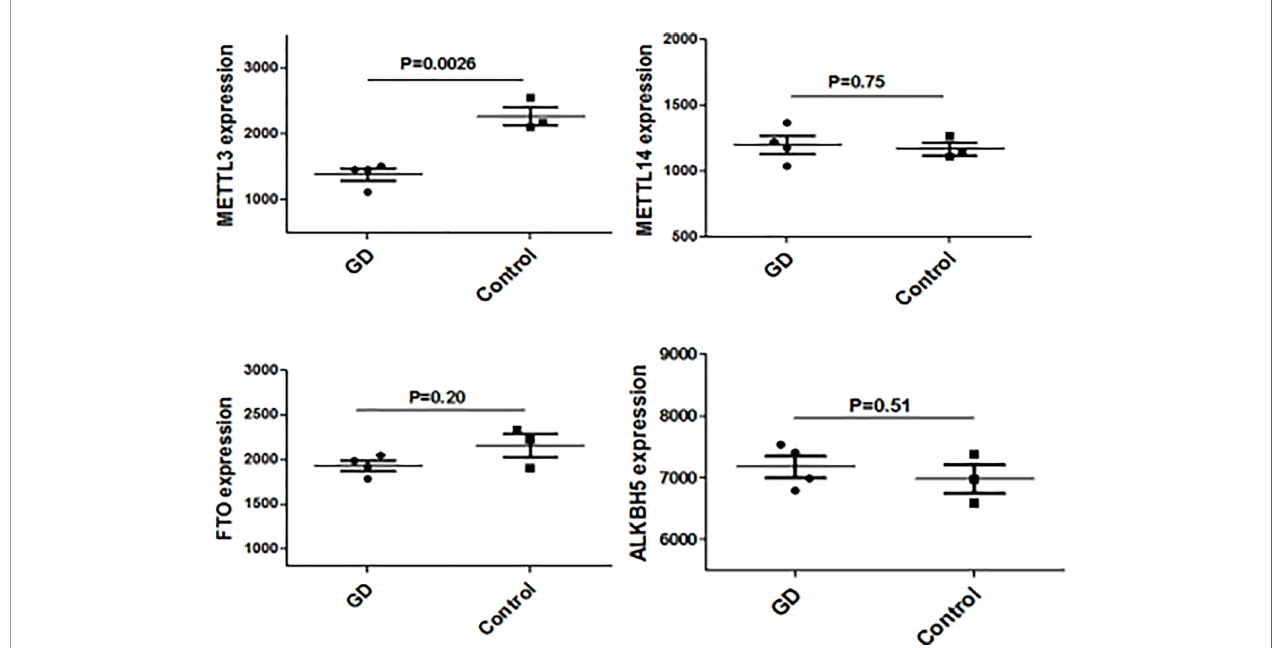
FIGURE 1 | METTL3 mRNA expressions in thyroid from GD and